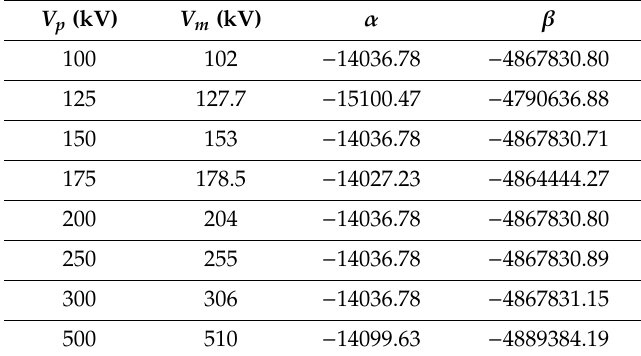
Table 2. Optimal parameters of the double exponential model to generate indirect lightning